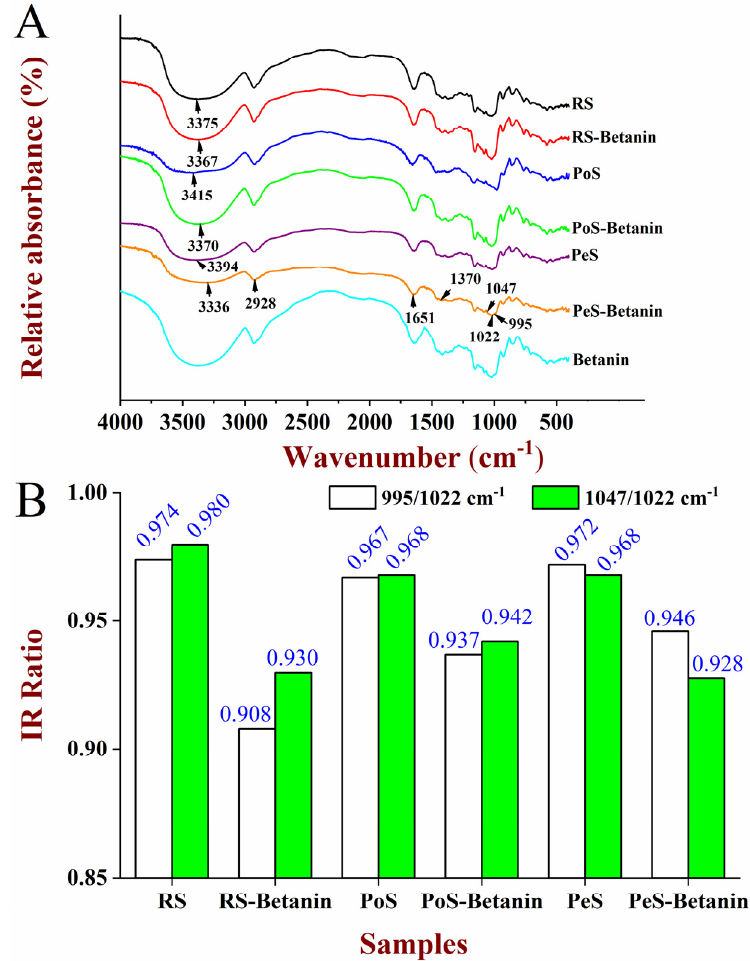
Figure 5. FTIR spectra ( A ) and 1047 cm − 1 /1022 cm − 1 ratios from deconvoluted FTIR spectra ( B ) of starches and starch–betanin samples after retrogradation for 7 days. RS: rice starch; PoS: potato starch; PeS: pea starch.